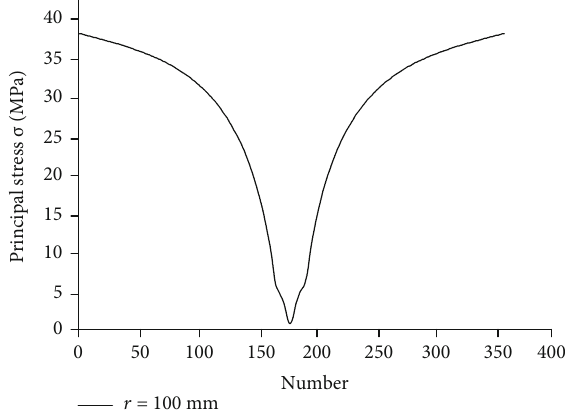
Figure 2: Distribution of principal stress.